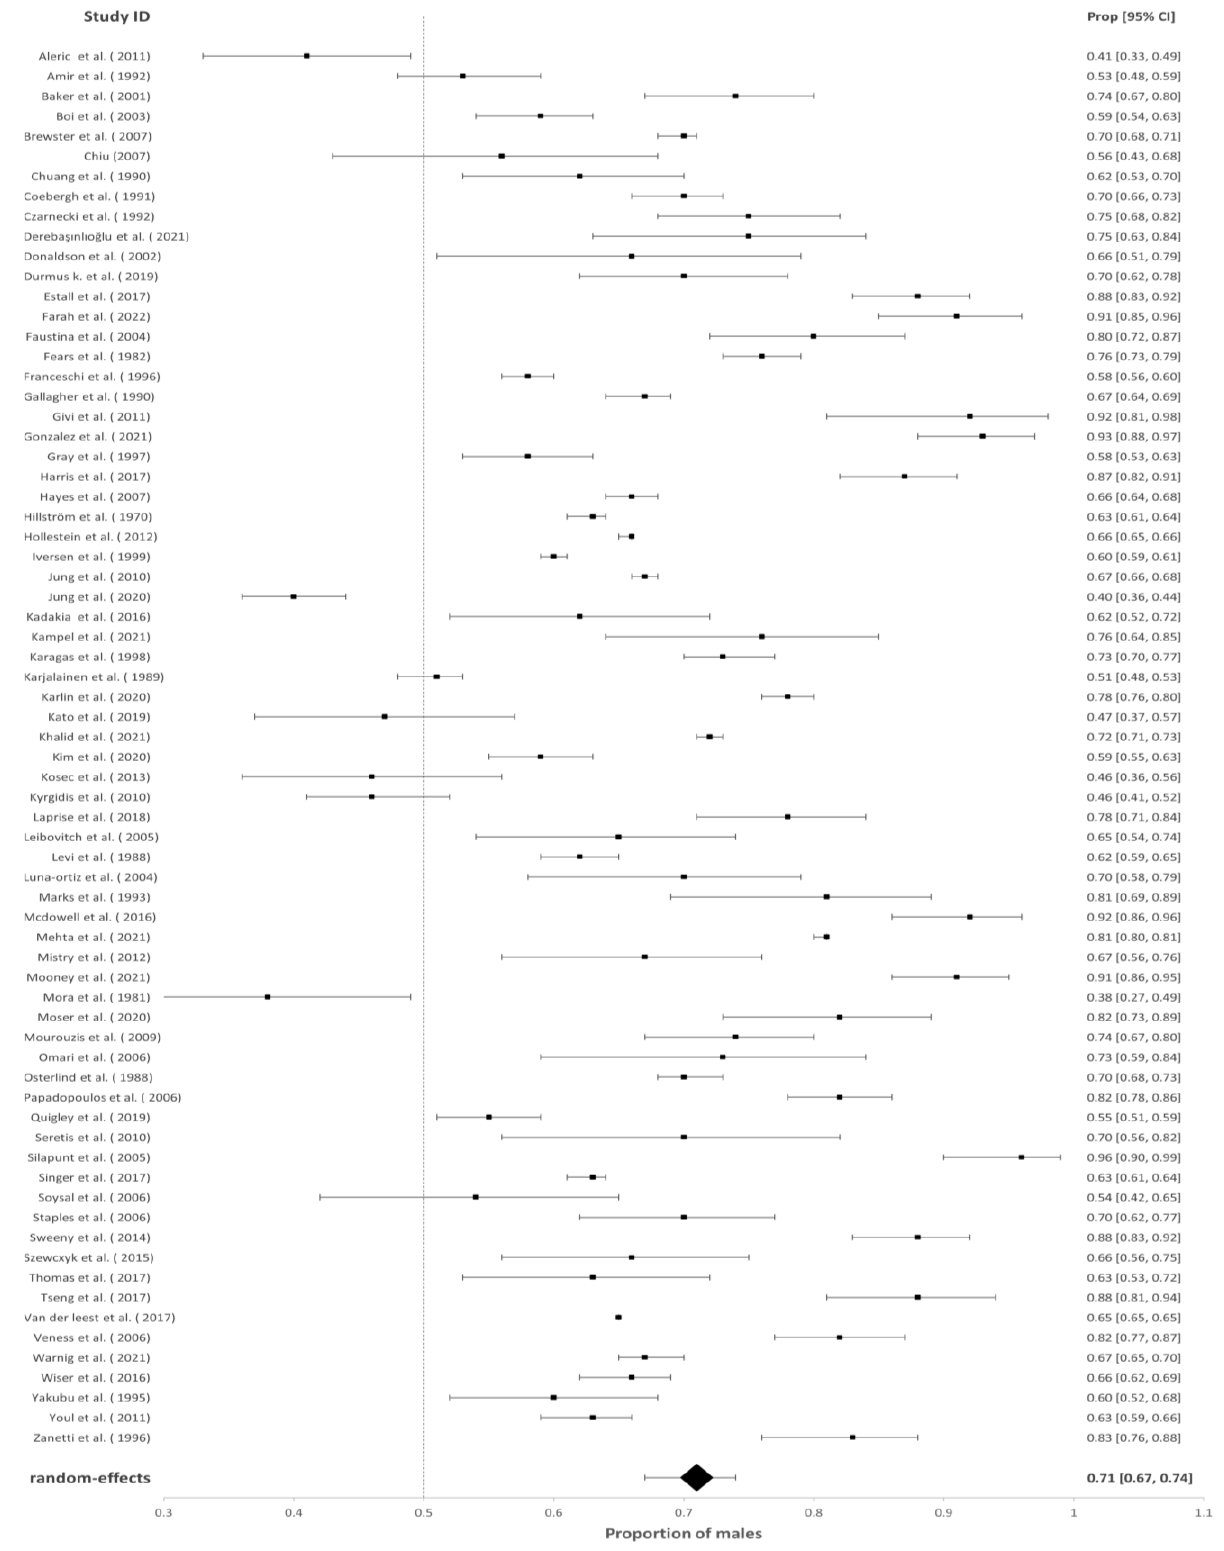
Figure 2. Proportion of males with cSCC of the total head and neck region.[17 – 76].